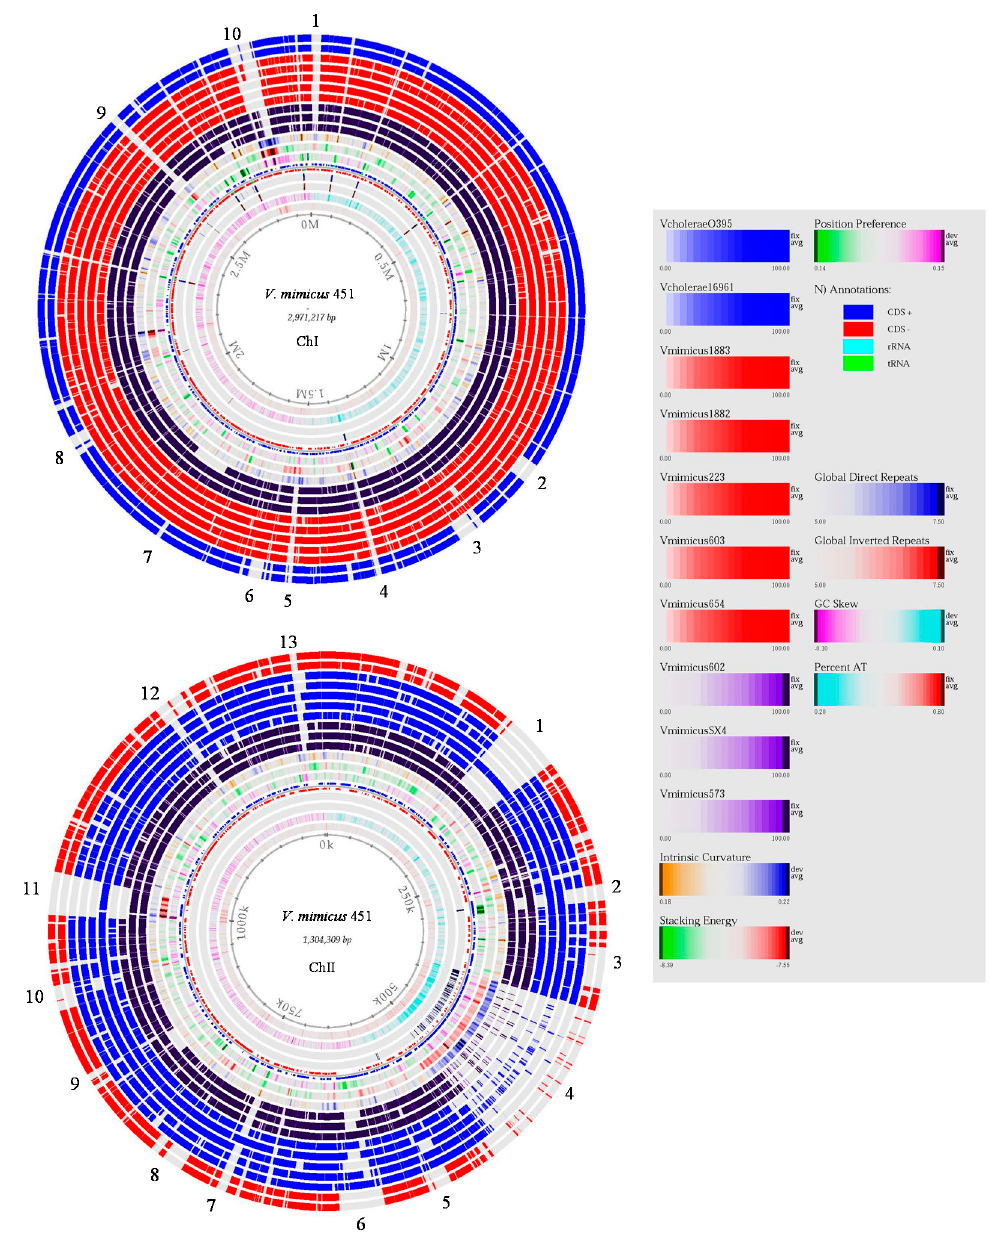
Figure 1. Genome BLAST atlas of both chromosomes of V. mimicus using V. mimicus MB451 as a reference. Order of the genomes from the inner dark circle: V. mimicus VM573, V. mimicus SX-4, V. mimicus CAIM-602 T , V. mimicus ATCC-33654, V. mimicus VM603, V. mimicus VM223, V. mimicus CAIM-1882, V. mimicus CAIM-1883, V. cholerae 16961, and V. cholerae